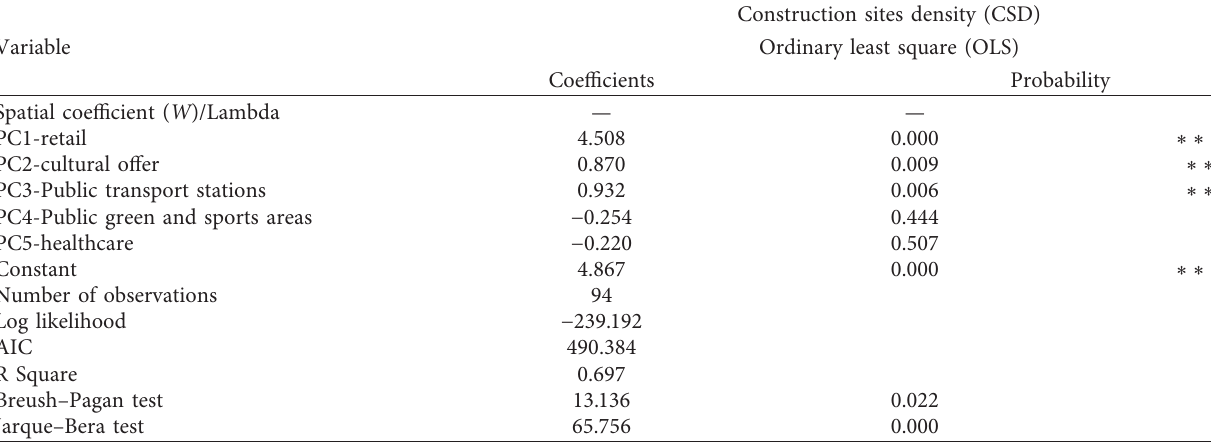
Table 6: Ordinary Least Squares (OLS) model and to assess the relationship between the CSD and the 5 PCs (source: authors’ elaboration).